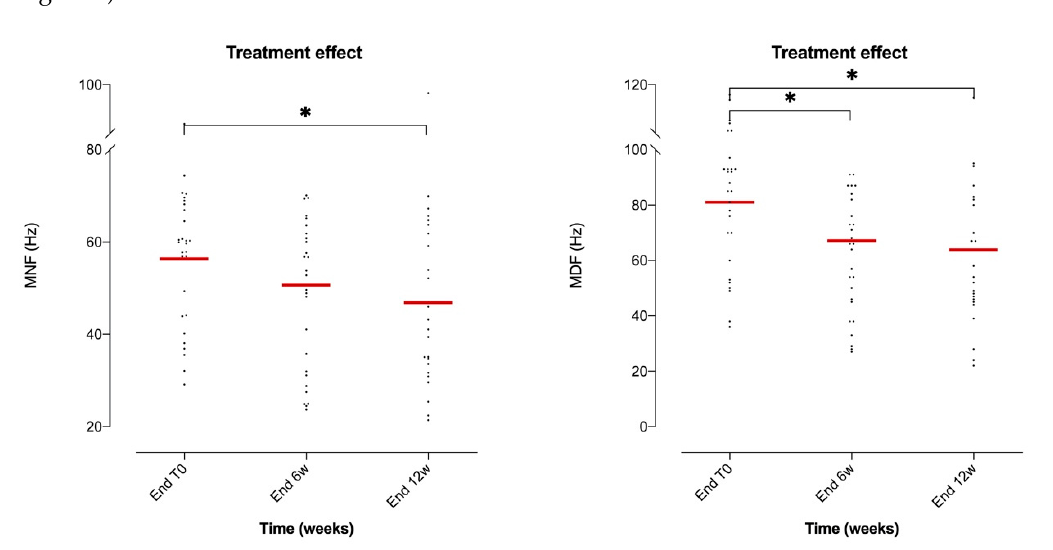
Figure 5. Scatter dot plot of the mean values of MNF (left graph) and MDF (right graph) of the AM muscle with respect to time of treatment (T0: first session; 6w: week 6; 12w: week 12). Data were compared at the end of the session (End). A gradually decrease trend, which was statistically confirmed, emerged at the end of the session in relation to the evolution of the treatment. *: p < 0.05 in the Tukey multiple-comparison test.